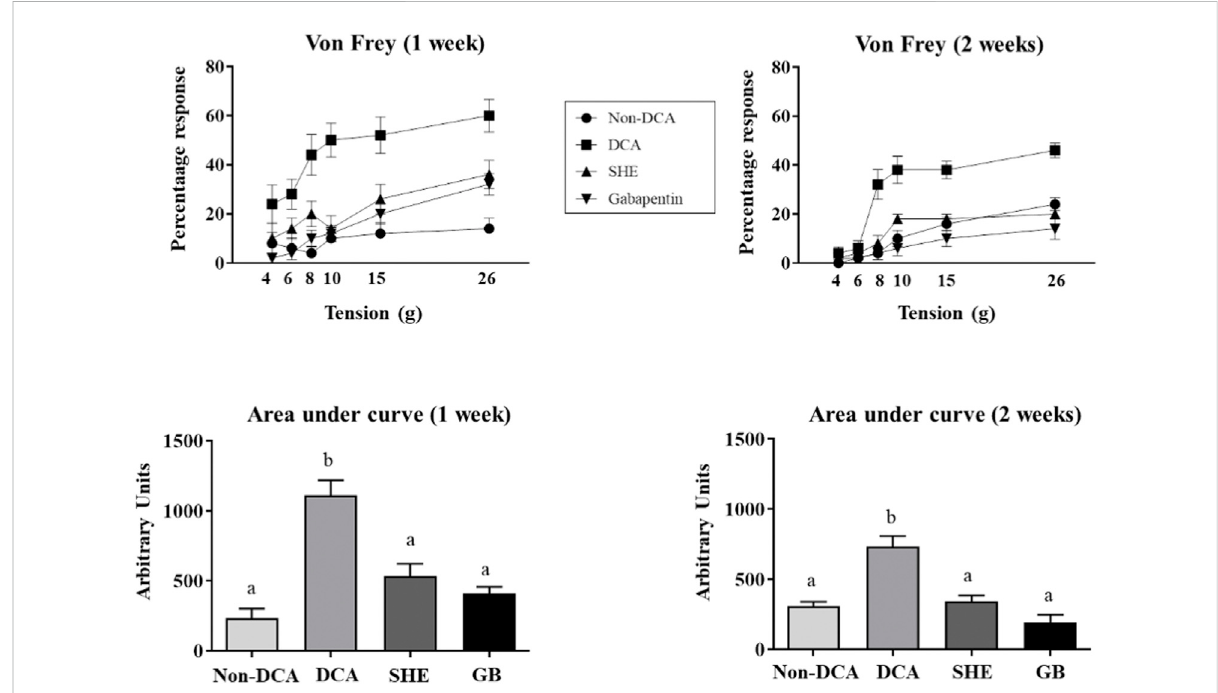
FIGURE 3 Assessmentofreferredhyperalgesiaoneand2 weeksafter DCAinstillation.VonFrey fi laments(1 – 8 g)wereappliedtothelowerabdomen( fi ve times for 1-2 s) of Serpylli herba extract (SHE) (100 mg/kg) or gabapentin (GB) (70 mg/kg) treated rats. Referred hyperalgesia was estimated considering percentage of response to von Frey fi laments and area under the curve (AUC) was calculated. Data are expressed as means ± SEM ( n = 10). Groups with different letters are statistically different ( p <